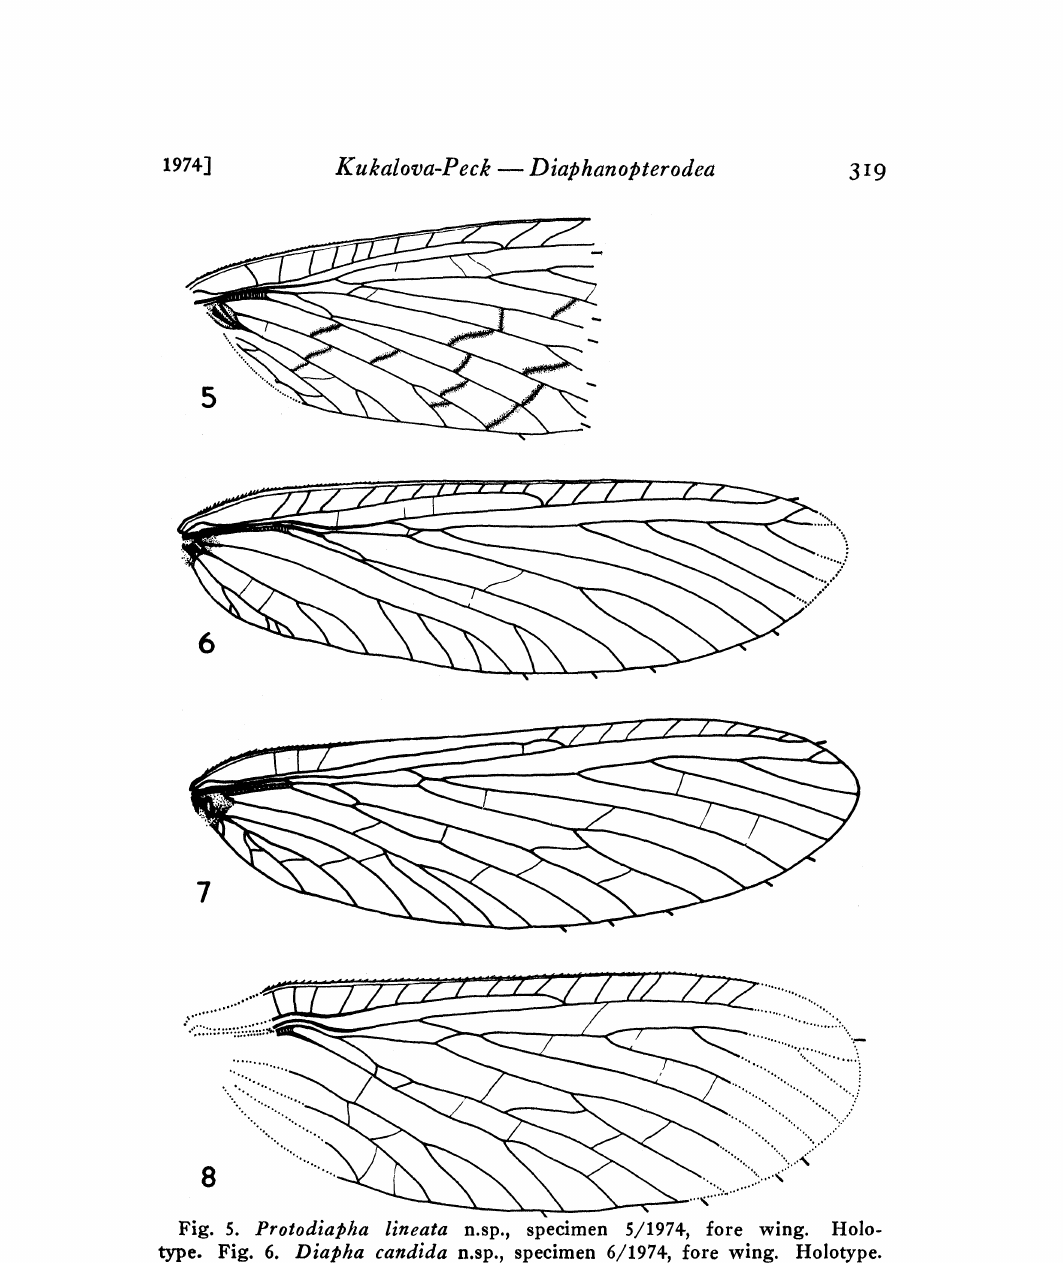
Fig. 5. Protodia2bha lineata n.sp., specimen 5/1974, tore wing. Holo- type. Fig. 6. Diapha candida n.sp., specimen 6/1974, fore wing. Holotype. Fig. 7. Diapha candida n.sp., specimen 7/1974, hind wing. Fig. 8. Per- modiapha cartenteri n.sp., specimen 11/1974, fore